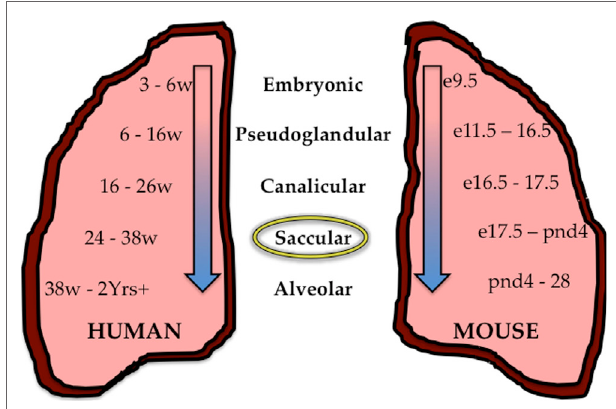
FiGURe 1 | Stages of lung development in the human and mouse . During development, the human (mouse) lung undergoes five successive stages of development; The Embryonic stage 3–6 weeks (e9.5–11.5), the Pseudoglandular stage 6–16 weeks (e11.5–16.5), the Canalicular stage 12–26 weeks (e16.5–17.5), the Saccular stage 24–38 weeks (e17.5–PND4), and the Alveolar stage 38 weeks–2 + years (PND4–28). Preterm children who survive are often born between 24 and 38 weeks of age and are in the saccular stage of development (circled) corresponding to the saccular stage in the mouse from